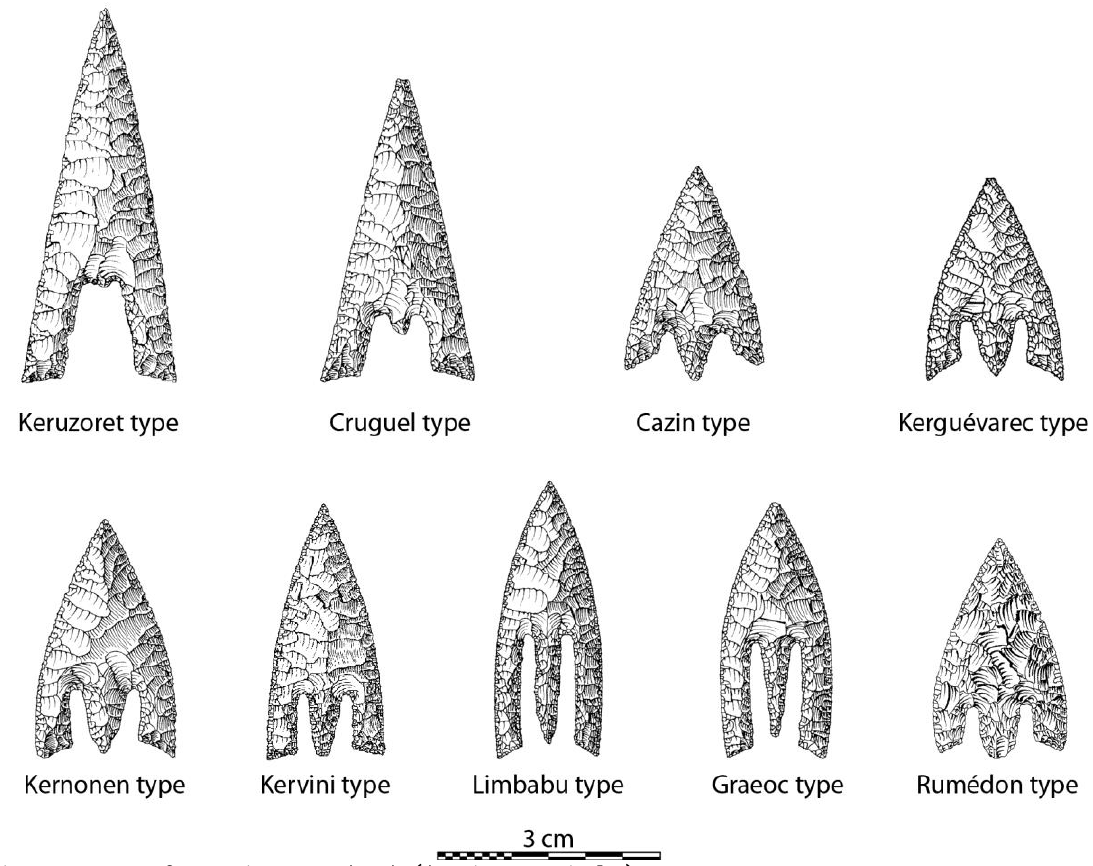
Figure 3. Types of Armorican arrowheads (drawings C. Nicolas). Table 1. Typology and inventory of the arrowheads found in the Early Bronze Age grave from